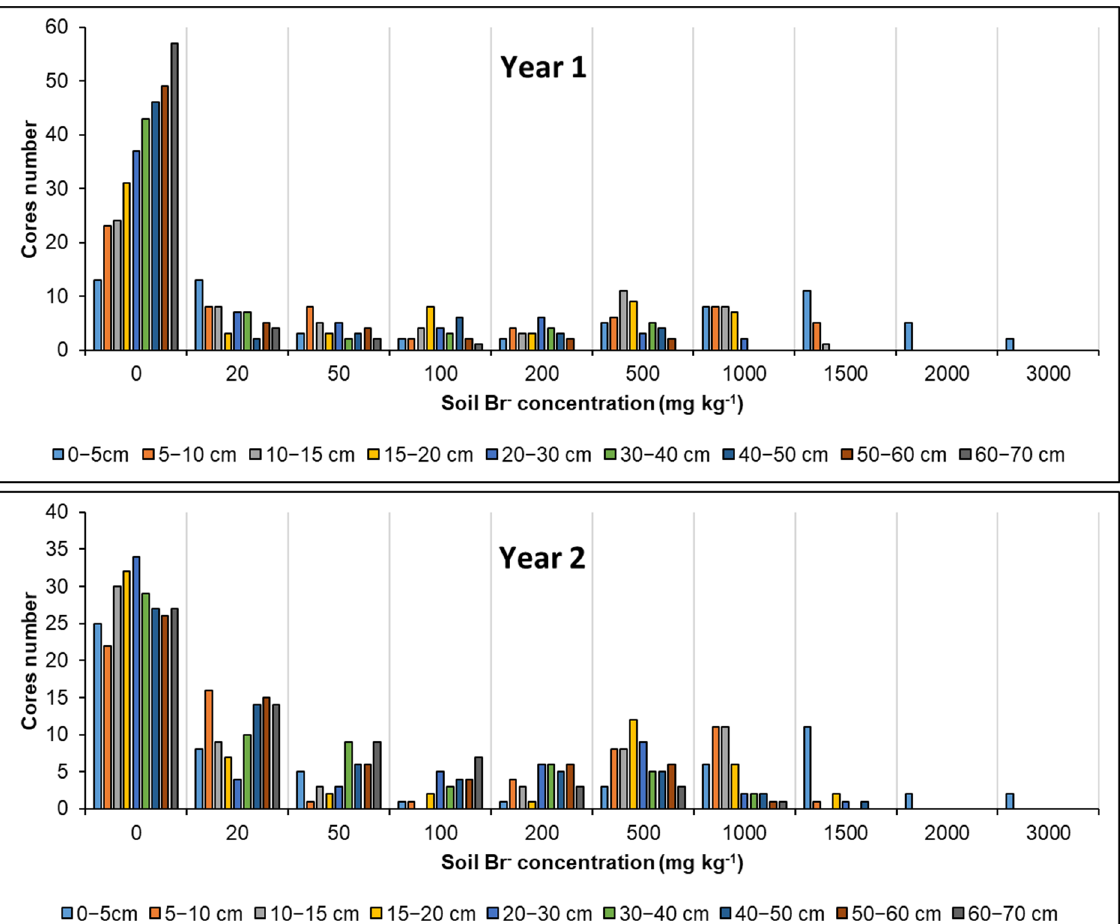
Figure 7. The number of cores and frequency of different Br − concentrations (mg kg − 1 ) in each layer of soil depth from 0 to 70 cm in year 1 and year 2. Different colors of each bar indicate each layer of soil depth.